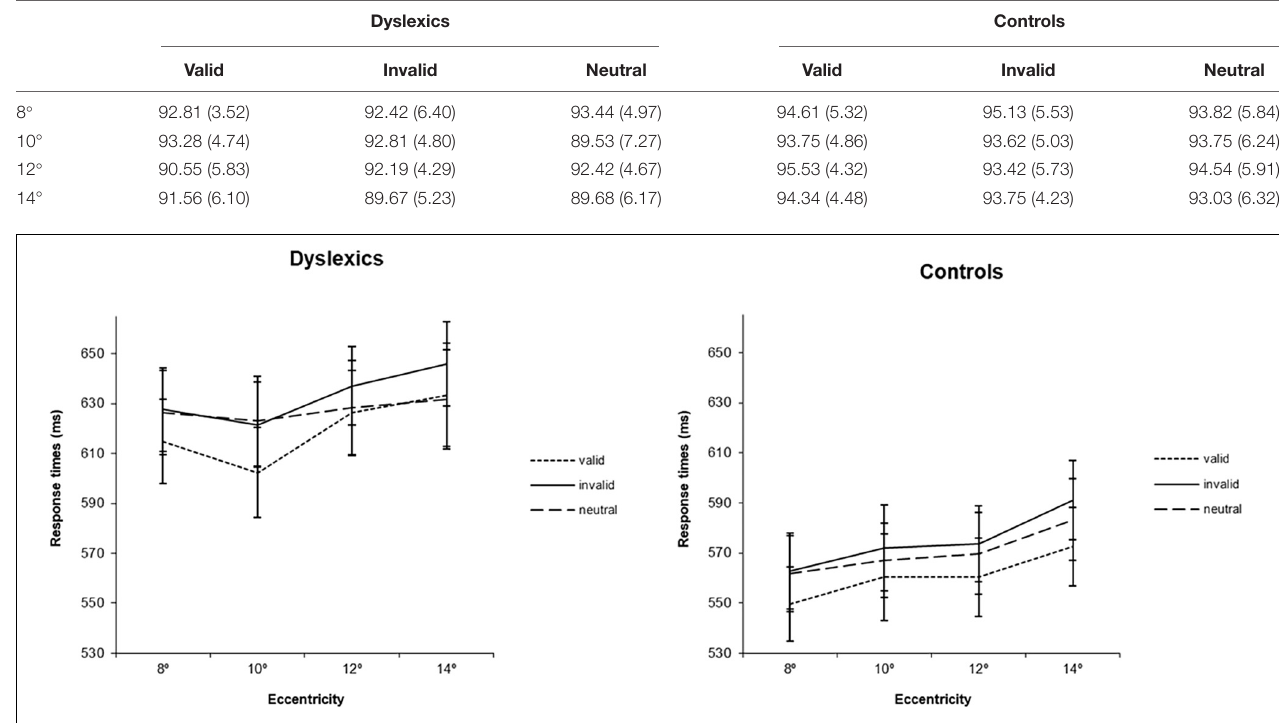
FIGURE 2 | Average response times (ms) for the three types of cues (valid, invalid and neutral) at four eccentricities (8 ◦ , 10 ◦ , 12 ◦ , 14 ◦ ) for dyslexics and controls. Error bars indicate ± SE.